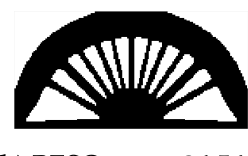
Table 3. Comparison of half-wheel beam optimization results. Optimization Method